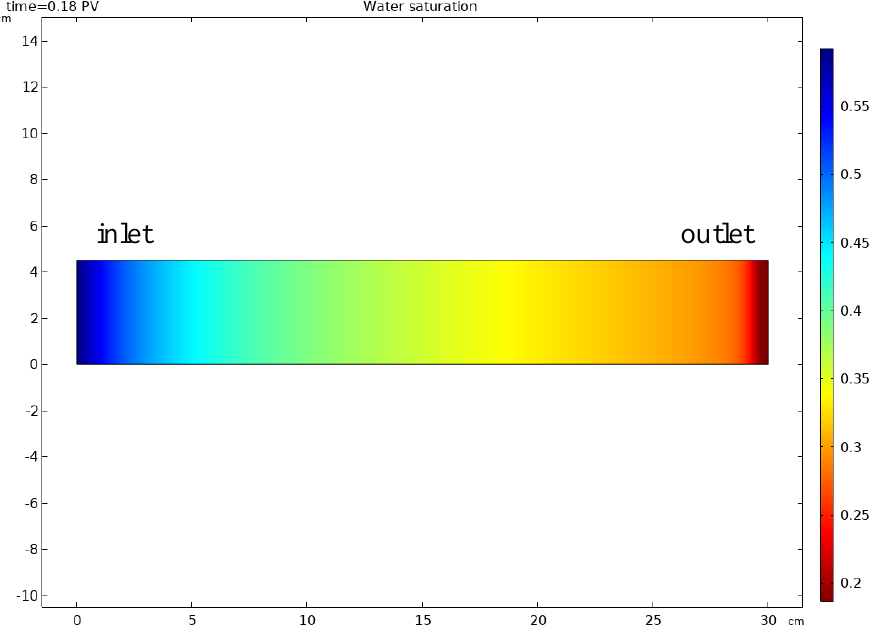
Figure 3. Schematic diagram of the homogeneous model simulation of displacement. The displacement was carried out by means of a constant flow rate at the inlet end and constant pressure at the outlet end. The flow rate was converted to 8.23 × 10 − 6 m/s through 1 mL/min in the physical experiment, and the outlet pressure was set to 0 mPa. The injection time was set as 180 min, which was converted into dimensionless time, namely the multiple of pore volume, as shown in Equation (1), then 180 min was approximately 1 PV: